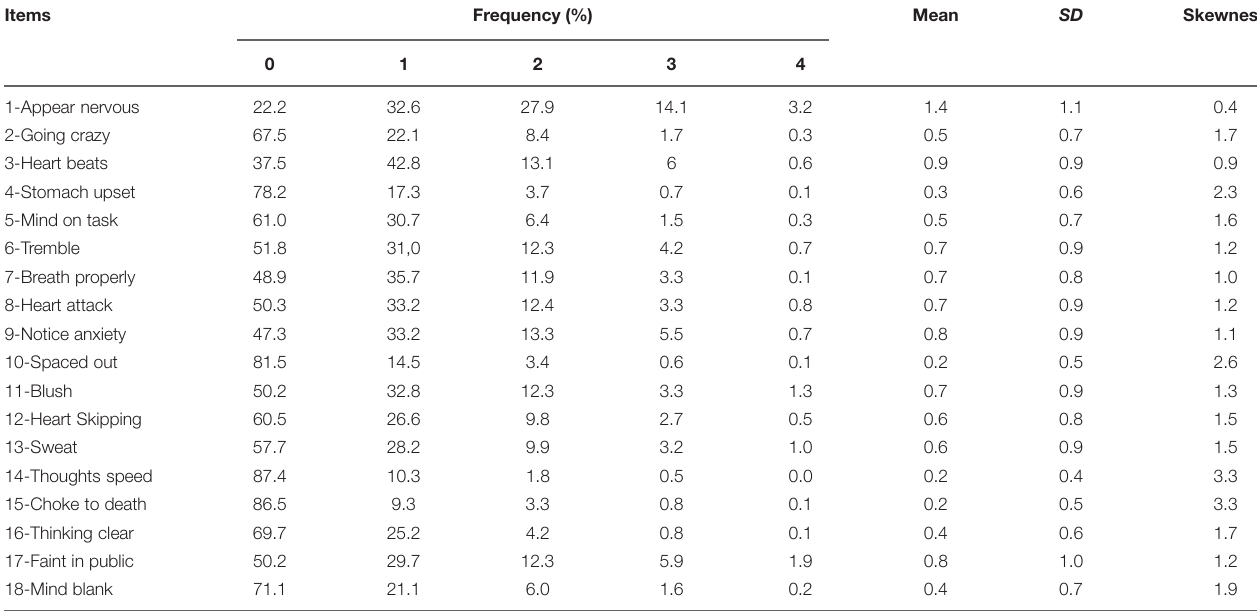
TABLE 1 | Descriptive statistics for ASI-3 items ( N = 1507).